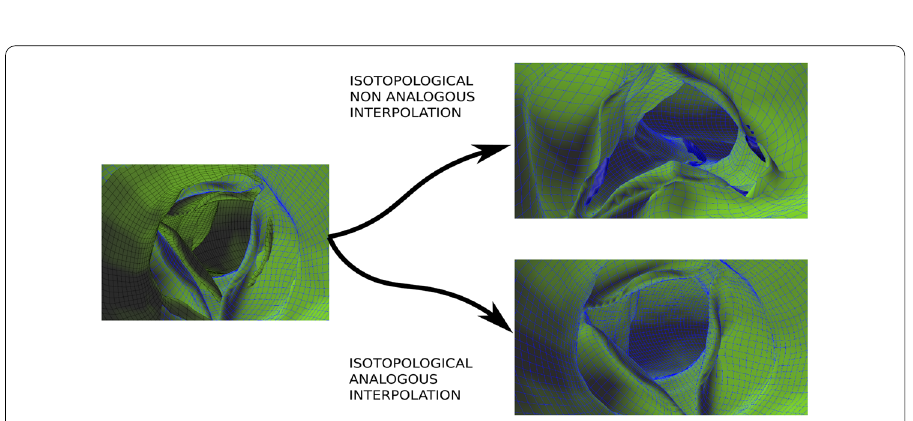
Fig. 20 Generated ventricle geometric snapshots (left). Real-time data-based model (right). Geometry is evaluated from the built reduced order model. Two geometries have been evaluated at phase 38 . 7% (systole) and 81% (diastole)